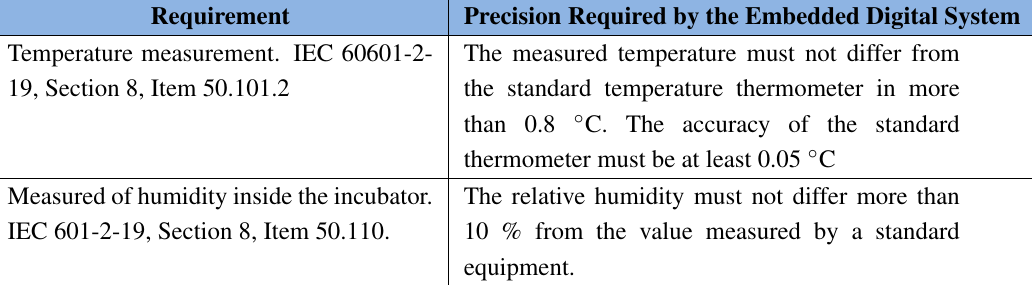
Table 1. Precision in the measurements of temperature and humidity specified by standard IEC 60601-2-19. Requirement Precision Required by the Embedded Digital System The measured temperature must not differ from the standard temperature thermometer in more than 0.8 ◦ C. The accuracy of the standard thermometer must be at least 0.05 ◦